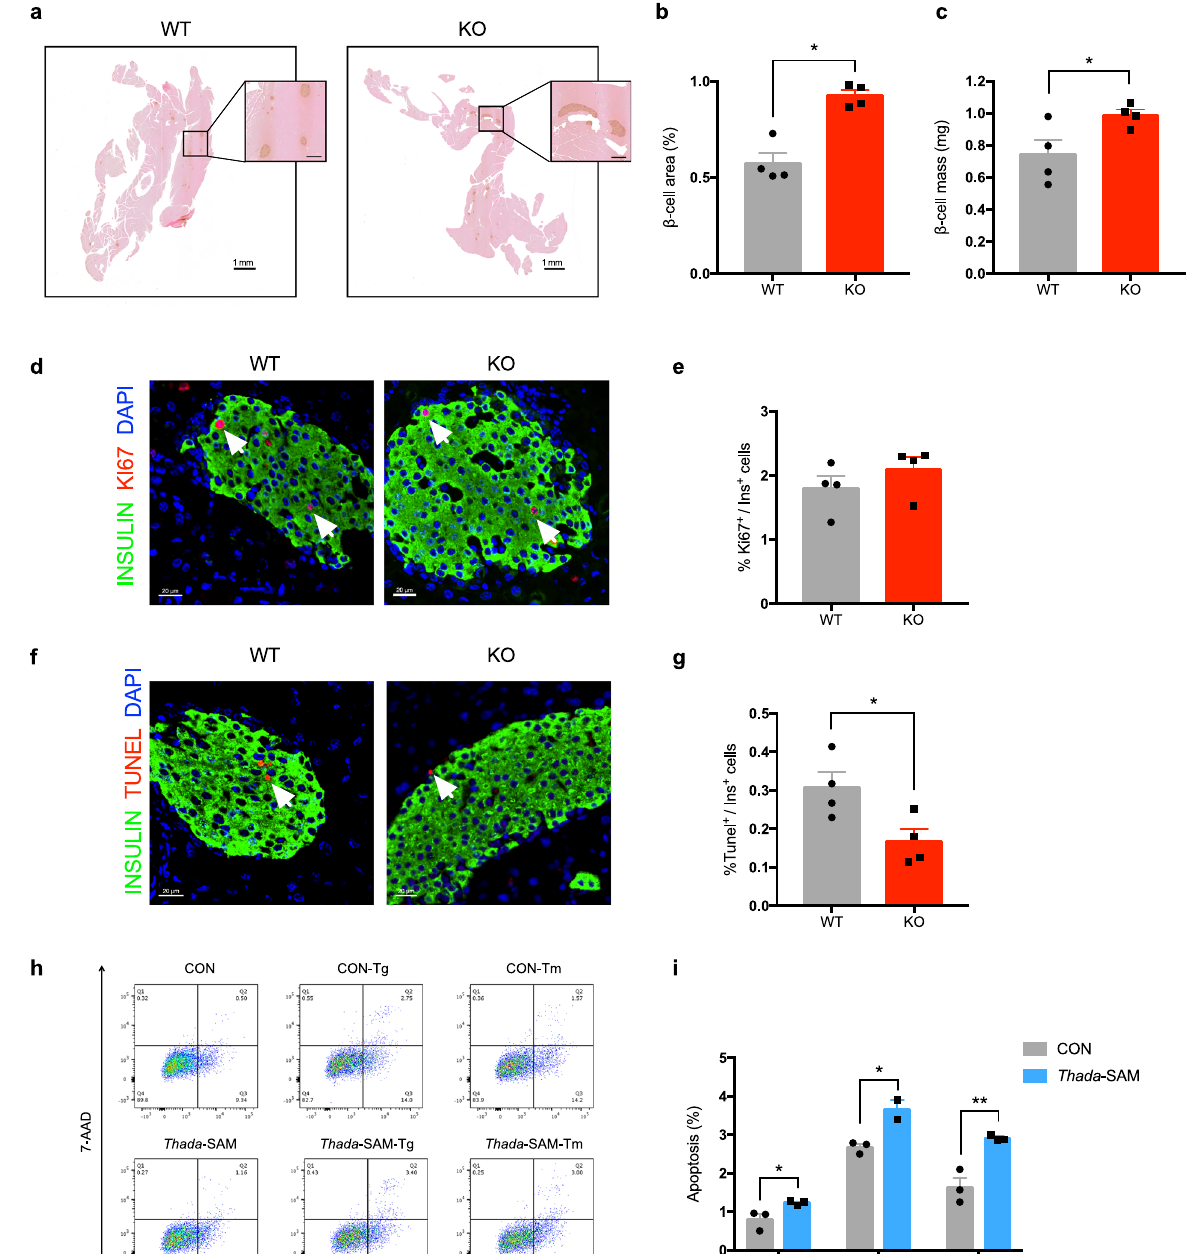
Fig. 4 | Thada -knockout mice have increased β -cell mass owing to reduced apoptosis.a Representative immunohistochemistryimagesofpancreaticsections fromWTand Thada -KOmicestainedforinsulin(brown)andeosin(red).Scalebars, 1mm for whole pancreas and 200 μ m for magni fi ed image. b Measurements of β - cellarea/pancreaticarearatioinWTand Thada -KOmice( n =4). c Measurementsof β -cell mass in WT and Thada -KO mice ( n =4). d Representative immuno- fl uorescence images of islets from WT and Thada -KO mice stained for insulin (green), Ki67 (red), and DAPI (blue). Scale bars, 20 μ m. Arrowhead points to Ki67 + Insulin + cells. e The proliferation of β -cell was determined by quanti fi cation thepercentageofKi67 + inInsulin + cells( n =4miceeachgroup).3428±600Insulin + cells were quanti fi ed for WT mice and 3328±533 Insulin + cells were quanti fi ed for KO mice. f Representative immuno fl uorescence images of islets from WT and Thada -KOmicestainedforinsulin(green),Tunel(red),andDAPI(blue).Scalebars,